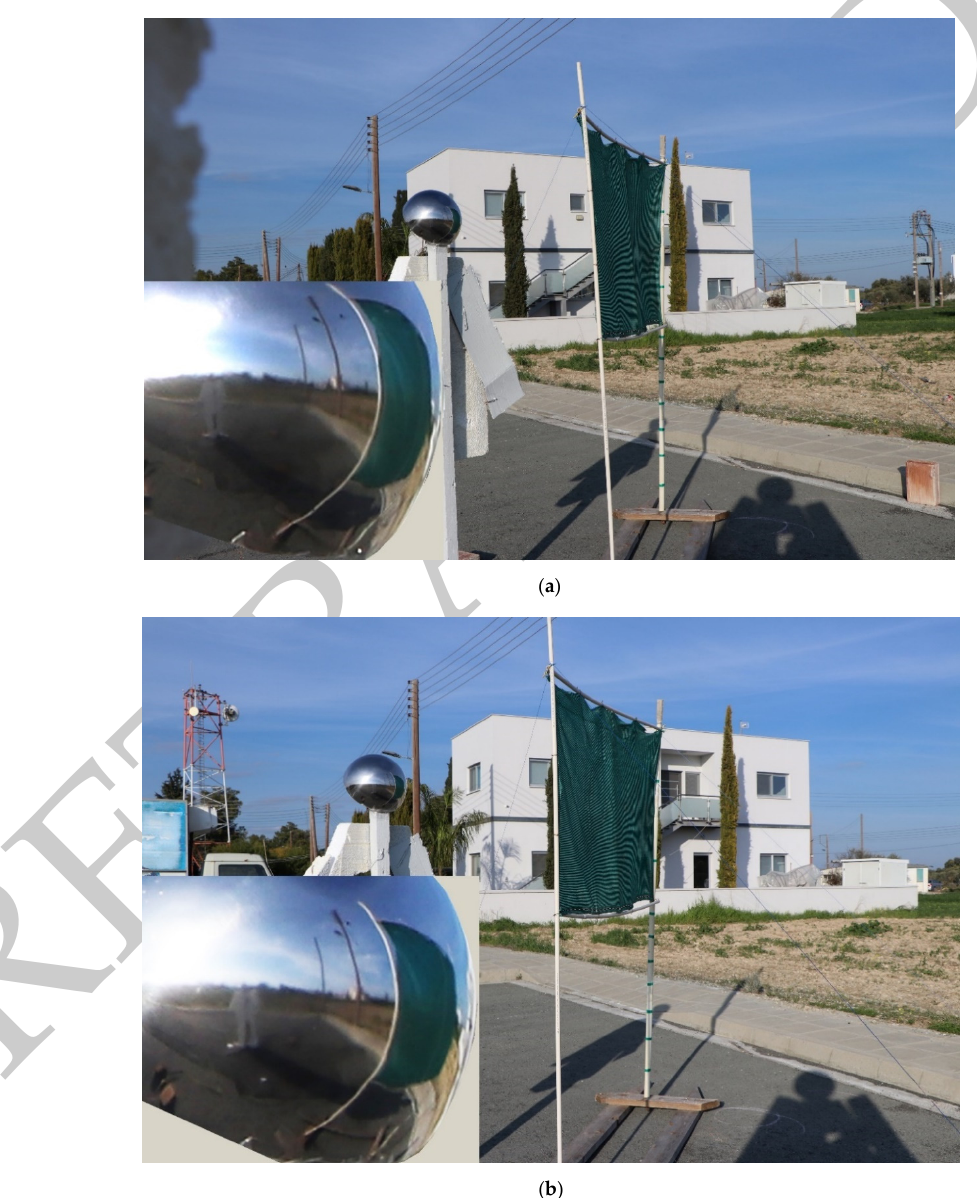
Figure 20. ( a , b ) Reproductions of photo AS17-134-20384 from different angles. The images taken at the correct position of the Sun (17° altitude), show the imaged astronaut, flag, and helmet and the photographer astronaut with its created shadow. Photos cleared from irrelevant objects.